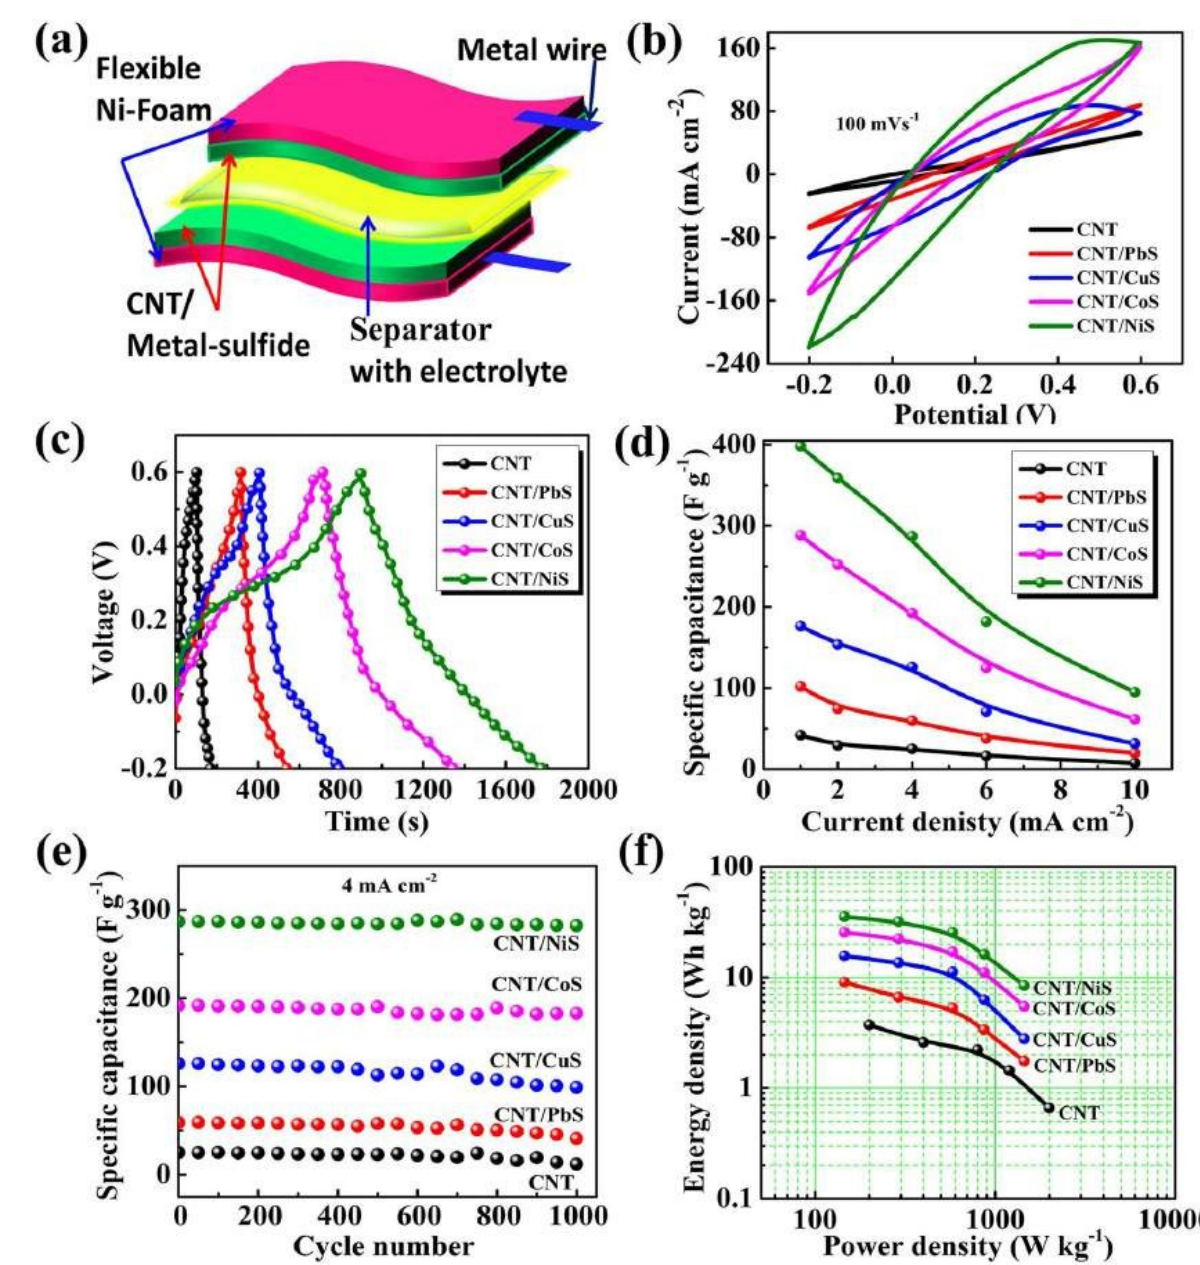
Figure 17. ( a ) Schematic of the flexible symmetric supercapacitor. ( b ) CV graphs for symmetric CNT/metal-sulfide supercapacitor devices at 100 mV s − 1 in polysulfide electrolyte. ( c ) Charge-discharge curve at 1 mA cm − 2 , ( d ) specific capacitance versus current density, ( e ) stability performance and ( f ) Ragone plot for symmetric CNT/metal-sulfide supercapacitor cells. Reproduced with permission from [94].